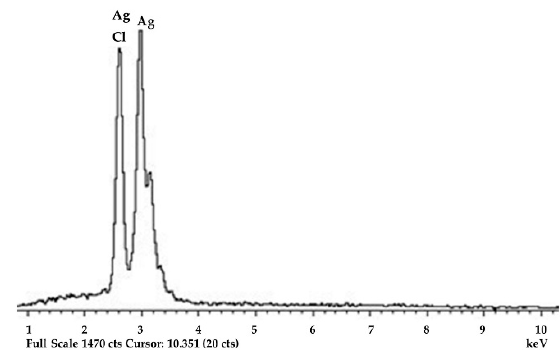
Figure 15. Spectrum associated with Ag-Cl (phase 2).